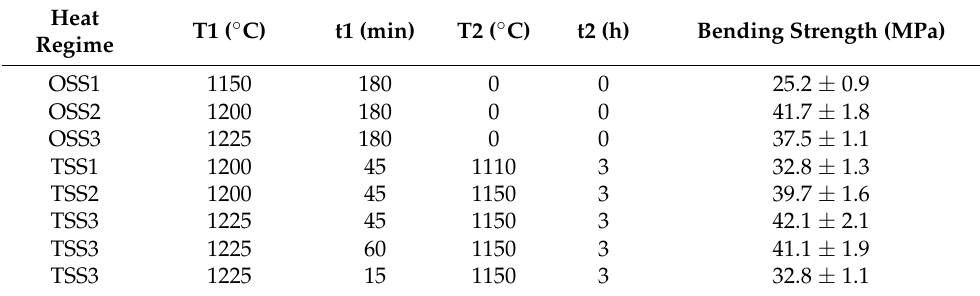
Table 2. List of sintering parameters and bending strength for OSS and TSS